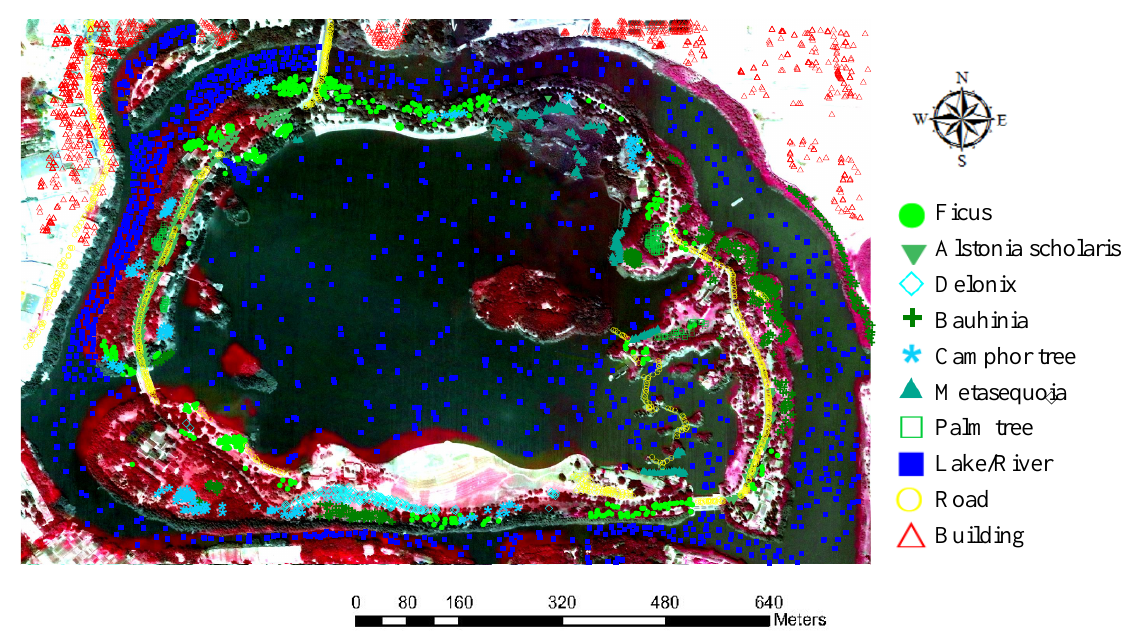
Figure 6. Three-band false color composite of the wetland data with sampling sites.